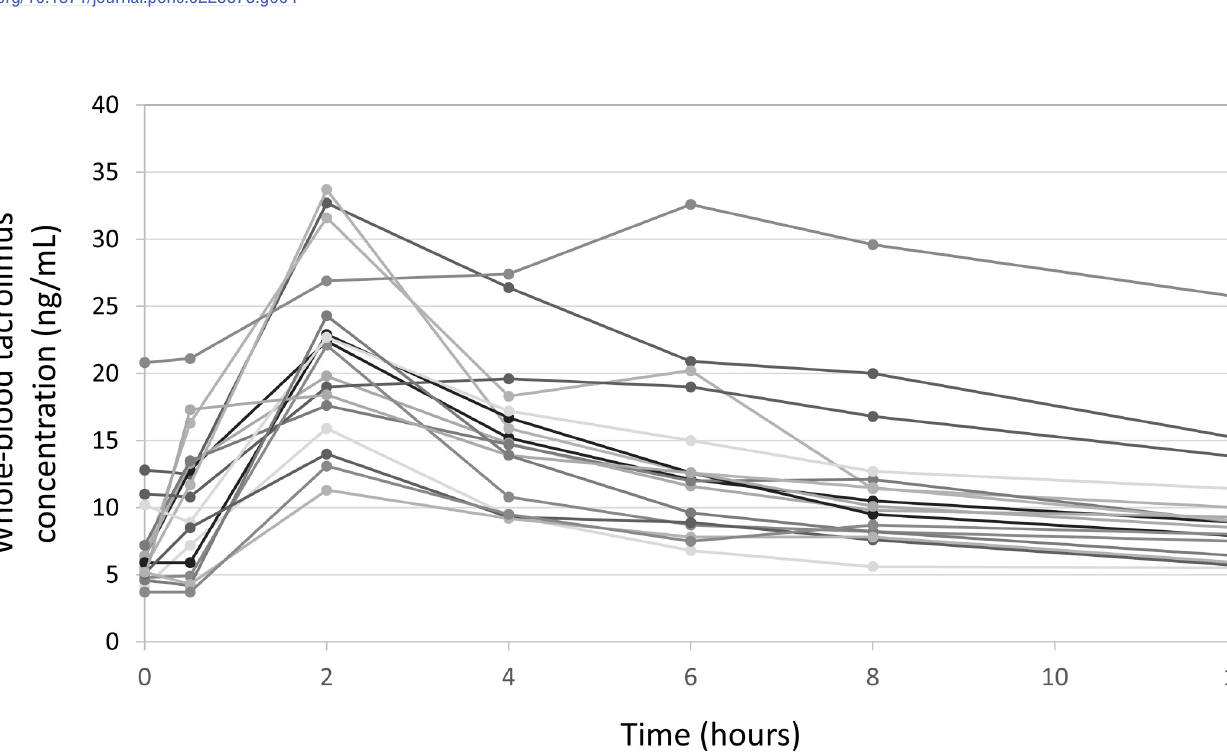
Fig 4. Scatter plots of predictive AUC on the x-axis versus measured AUC on the y-axis for the study group patients. The predicted AUC estimated with a multiple regression equation provided the closest approximation to the actual value of AUC 0-12 using three time points with C 2 , C 4 , and C 6 (A), and two time points with C 2 and C 6 (B). Very high correlations were observed from a total of 79 tacrolimus concentration-time curves, as well as from those observed separately at the post-operative period 1 week, 3 weeks, 8 weeks and 12 months (A, B).